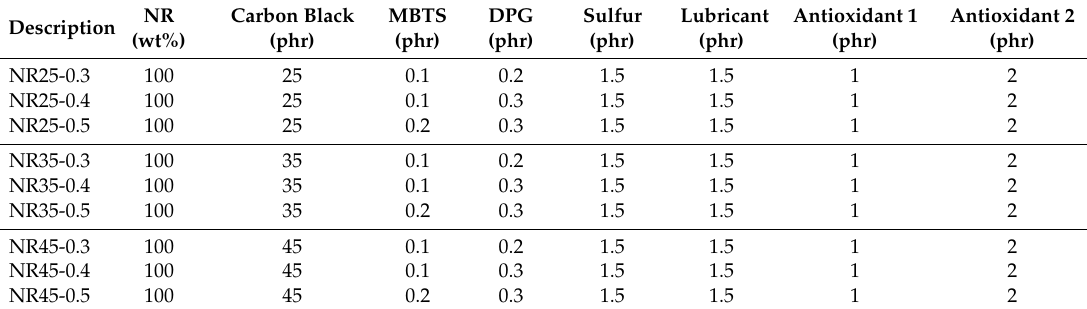
Table 1. Formulations of plasticized natural rubber (NR) compounds.